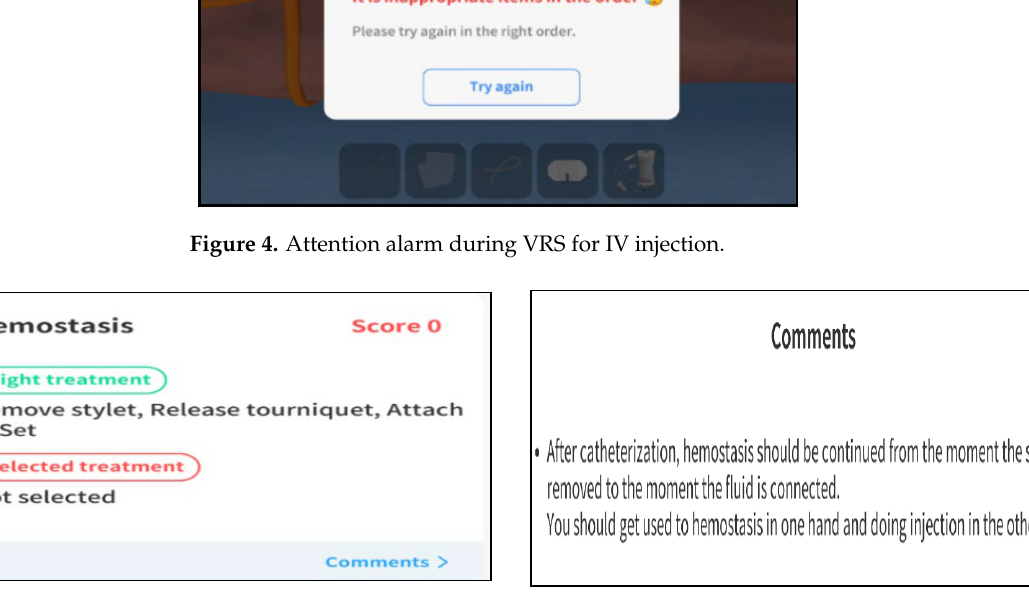
Figure 5. Evaluation system in the VRS for IV injection.